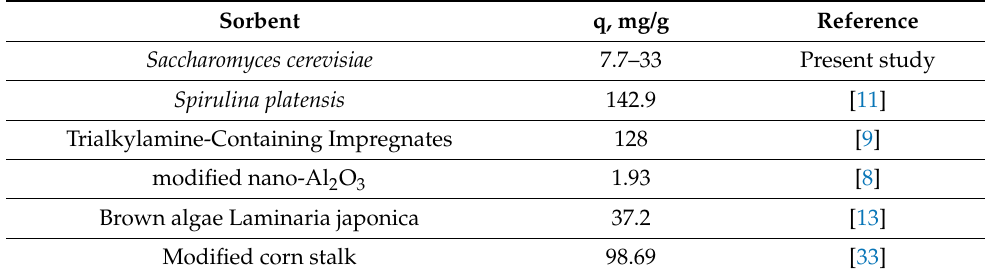
Table 4. The comparison of sorption capacity of yeast biomass sorbents with literature data.